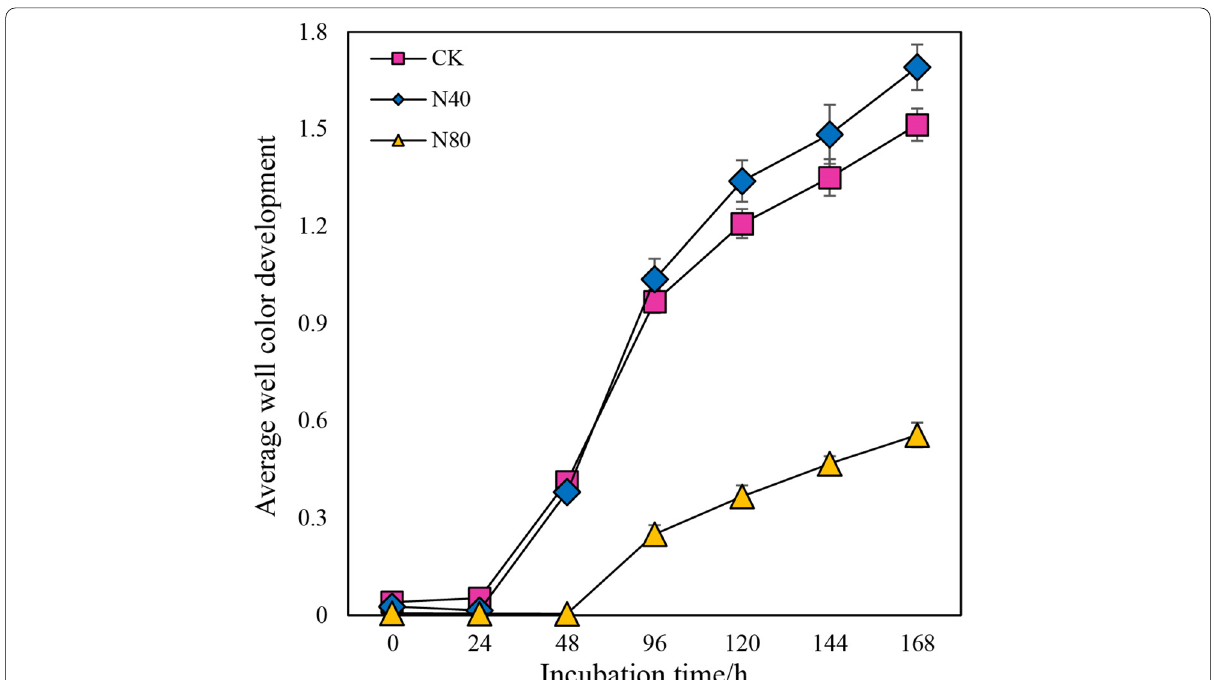
Fig. 1 Average well color development (AWCD) of the soil microbial community under different nitrogen addition concentrations as a function of incubation